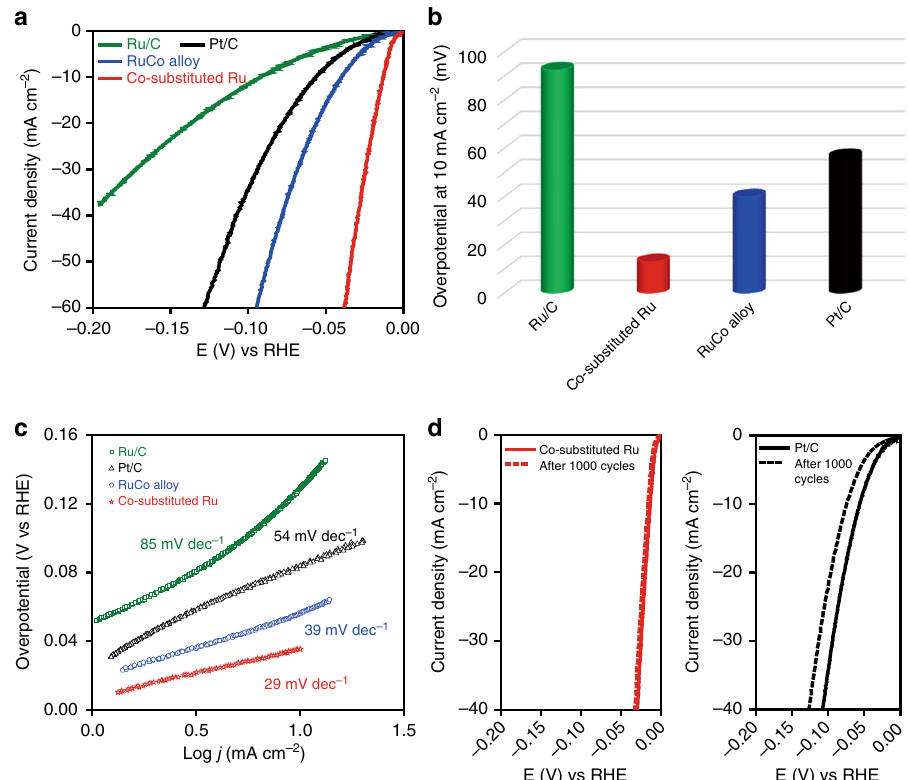
Fig. 3 Comparison of catalytic ability of Ru/C, Pt/C, RuCo alloy and Co-substituted Ru. a LSV curves, scan rate: 5 mV s − 1 . b Overpotentials at 10 mA cm – 2 of Ru/C, Pt/C, RuCo and Co-substituted Ru. c Tafel plots of Ru/C, Pt/C, RuCo and Co-substituted Ru in 1 M KOH. d Durability test of Pt/C and Co-substituted Ru, the LSV curves measured before and after 1000 cycles at a scan rate of 5 mV s −